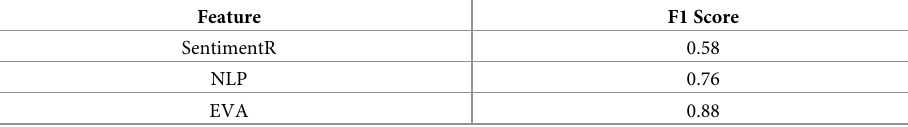
Table 3. A table of student grade prediction accuracy scores for the DEEP journals. Predictions made through MLP using the EVA features are the clear winners.